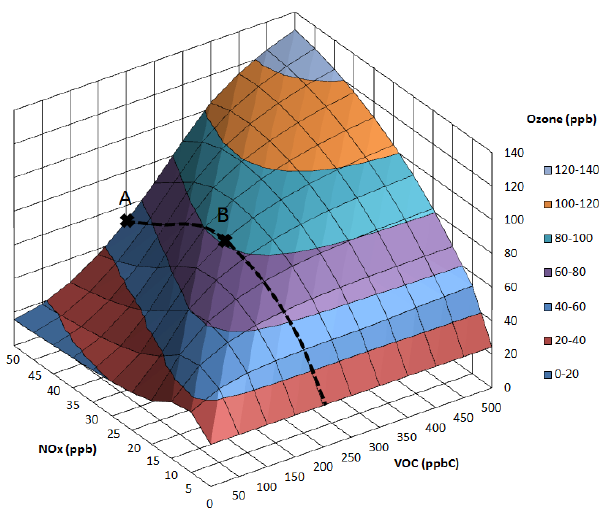
Fig. 1. Representative response of maximum 1h average ozone (ppb) to morning concentrations of emitted NO x and VOC. Section through points A and B is the ozone response to NO x at constant VOC of